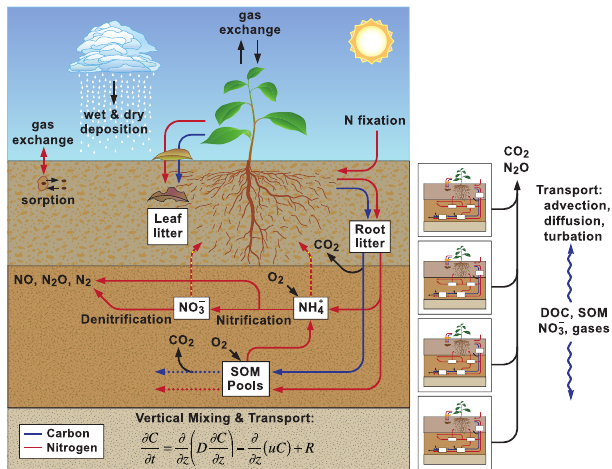
Fig. 1. Model structure of CLM4-BeTR: the example is based on the carbon and nitrogen